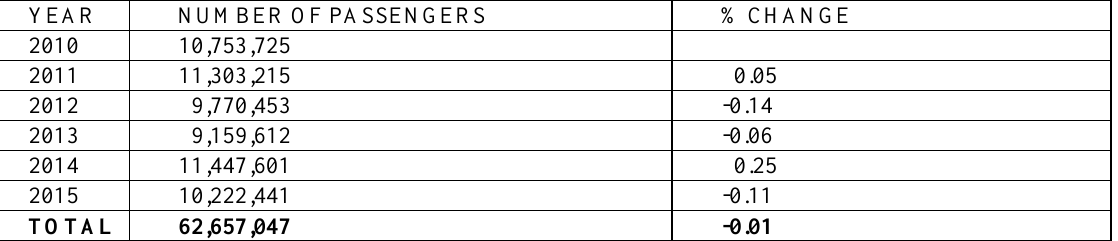
Table 3. Total domestic air passenger movement in